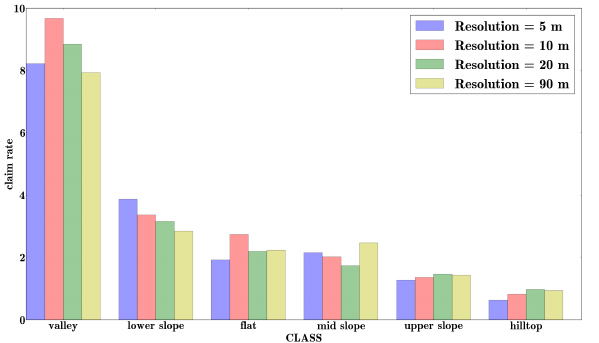
Figure 10: Claims Rate for different resolutions lower resolution DSMs are retrieved by downsampling the high resolution DSM using linear